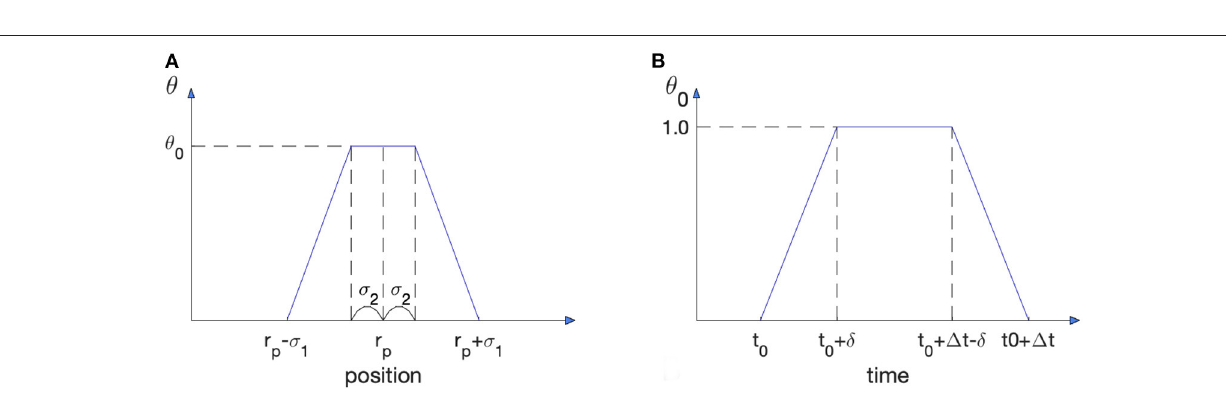
FIGURE 3 | Spatio-temporal characteristics of treatment induced by actuation. (A) Treatment substance distribution in space. The actuator is located at r = r p . (B) Time dependence of the actuator amplitude.